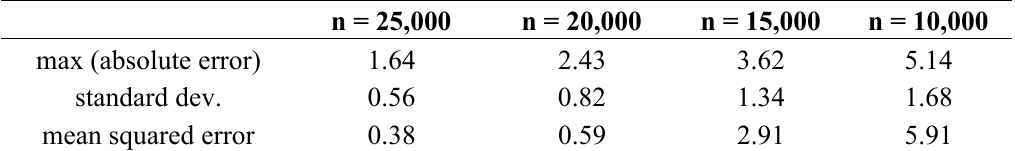
Table 6. Results for Expert 2 with n = 25,000; n = 20,000; n = 15,000 and n = 10,000. n = 25,000 n = 20,000 n = 15,000 n = 10,000 max (absolute error) 1.26 2.14 standard dev.